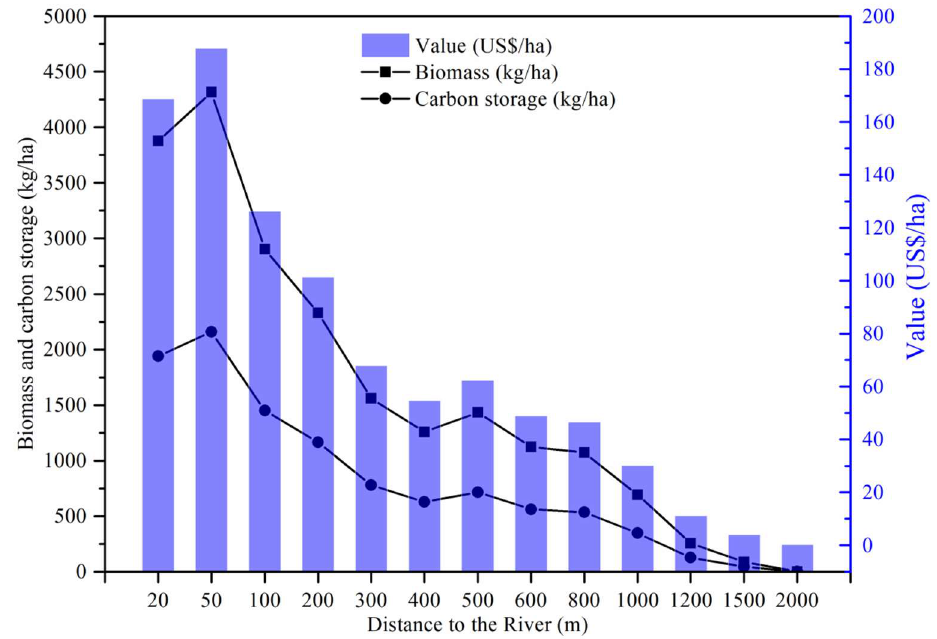
Figure 7. Biomass, carbon storage, and value of ecosystem service of P. euphratica forests at different distances from the river.